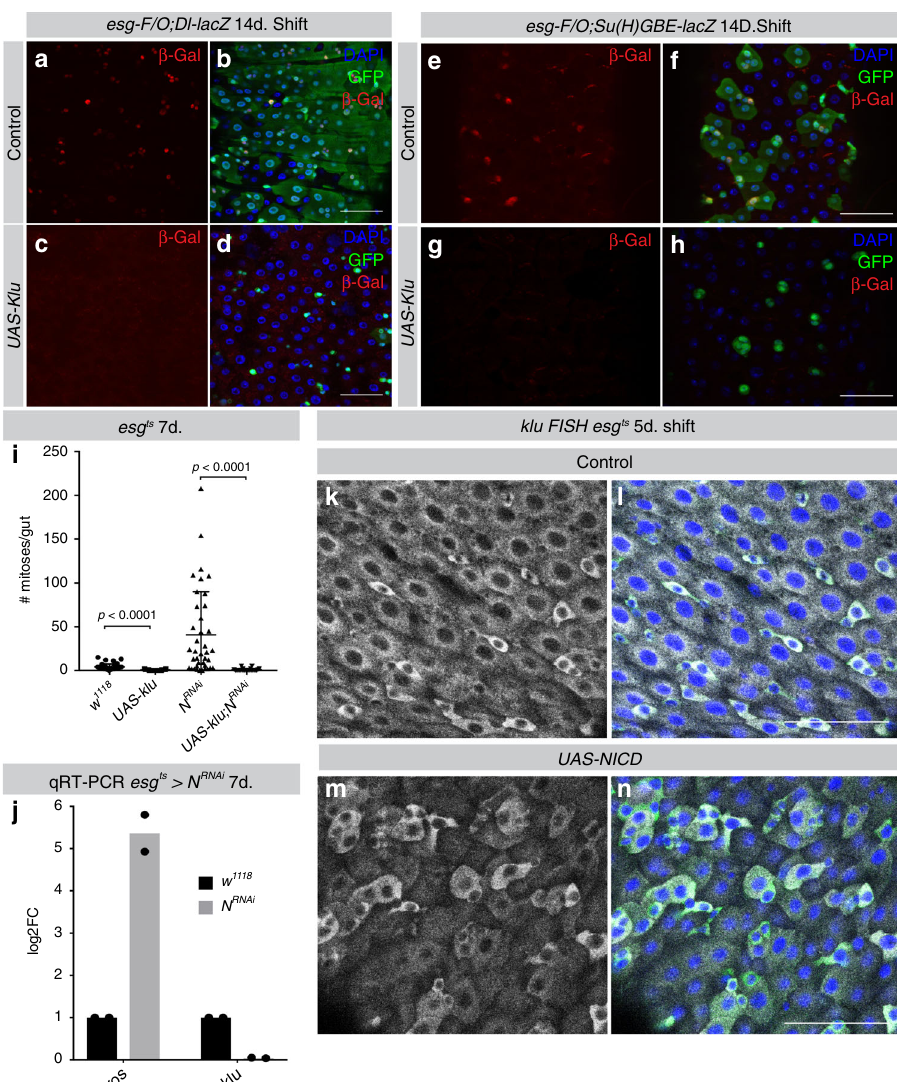
Fig. 4 Klu is regulated by Notch and represses Notch-induced tumor formation. a , b Control esg-F/O clones always contain 1 or more ISCs expressing Dl- lacZ . c , d esg-F/O > UAS-klu clones have no detectable Dl-lacZ expression. e , f Similarly, control esg-F/O clones contain EBs expressing Su(H)-GBE-lacZ, but not esg-F/O clones expressing UAS-klu ( g , h ). Representative areas of posterior midgut are shown. n = 3 midguts examined/genotype in a – h . i Quantif i cation of the number of mitoses per midgut in esg ts guts expressing N RNAi alone or in combination with UAS-klu . Klu expression also reduced mitosis compared to control midguts ( esg ts × w 1118 , control average = 4.2 mitoses/midgut, compare to UAS-klu : 0.48 mitoses/midgut, P < 0.0001). n = 42 for control (crossed with w 1118 ) esg ts animals and N RNAi animals, n = 33 for UAS-klu and n = 24 for UAS-klu ; N RNAi . j Quantitative real-time PCR of sorted esg ts GFP + cells expressing N RNAi for the EE-marker Pros and Klu. cDNA was derived from two replicates/genotype, each replicate containing mRNA isolated from esg ts GFP + cells from 100 midguts/genotype. k – n Fluorescent in situ hybridization for a klu probe showed induced expression in esg ts GFP + cells that overexpress constitutively active Notch intracellular domain (NICD, m , n ) compared to control esg ts cells ( k , l ). Representative areas of posterior midgut are shown. n = 4 midguts examined/genotype in k – n . Scale bar = 50 µ performing qRT-PCR for prospero ( pros ) and scute ( sc ). The EE noticed that the distance between control and klu RNAi sample marker pros was upregulated 5-fold upon klu RNAi (Fig. 5b). The groups and the UAS-klu group in the largest principal component PC1 is much larger (Supplementary Fig. 5a). This indicates more profound transcriptional changes in the UAS-klu samples com- pared to controls than between klu RNAi and controls. This is also re fl ected in the FACS-pro fi le of Esg + cells expressing klu RNAi and UAS-klu : whereas ISC and EB population sizes appeared similar between control and klu RNAi , the UAS-klu -expressing Esg + cells showed a loss of clearly distinguishable ISC and EB compartments (Supplementary Fig. 5b – d). We fi rst con fi rmed that the tran- scriptome of esg ts > klu RNAi sorted cells indeed re fl ects the excess EE differentiation phenotype seen in klu RNAi animals by